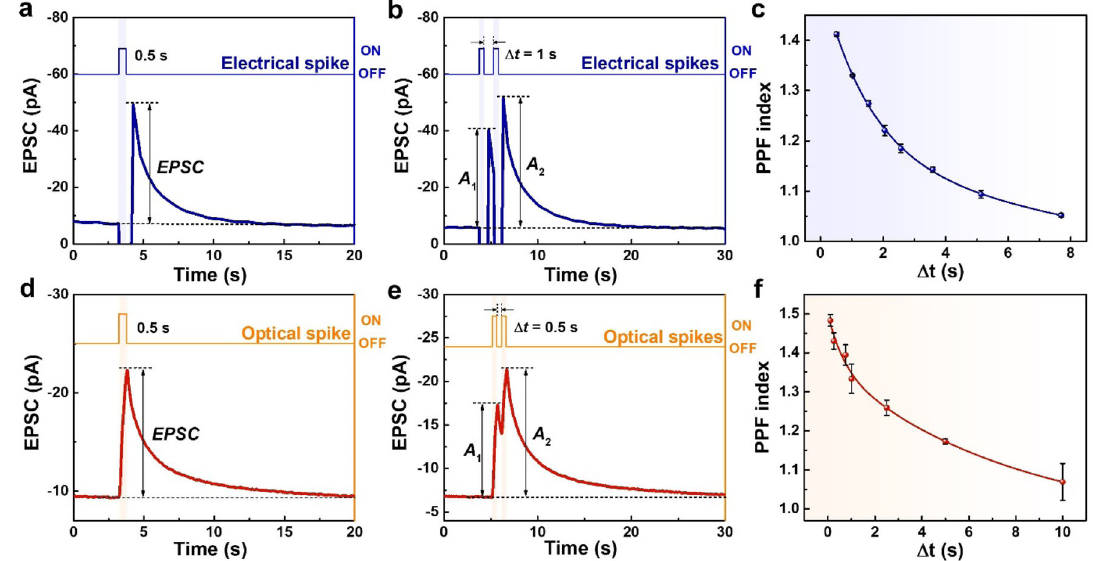
Fig. 2 Typical synaptic behaviors mimicked by the optoelectronic synaptic transistor. a EPSC evoked by an electrical spike ( − 2 V, 0.5 s). b EPSC evoked by a pair of successive electrical spikes ( − 2 V, 0.5 s) with an interval time of 1 s. c PPF index as a function of electrical spike interval with a fi xed gate voltage of − 2 V and a spike duration of 0.5 s. The blue solid curve is fi tting with an exponential function. Error bars represent standard errors of the optoelectronic synaptic transistor investigated by three independent measurements. d EPSC evoked by an optical spike (665 nm, 0.50 mW cm − 2 , 0.5 s). e EPSC evoked by a pair of successive optical spikes (665 nm, 0.14 mW cm − 2 , 0.5 s) with an interval time of 0.5 s. f PPF index as a function of optical spike interval with fi xed optical spike parameters (665 nm, 0.14 mW cm − 2 , 0.5 s). The red solid curve is fi tting with an exponential function. Error bars represent standard errors of the optoelectronic synaptic transistor investigated by three independent measurements. All the measurements of synaptic characteristics are performed at V D = − 1